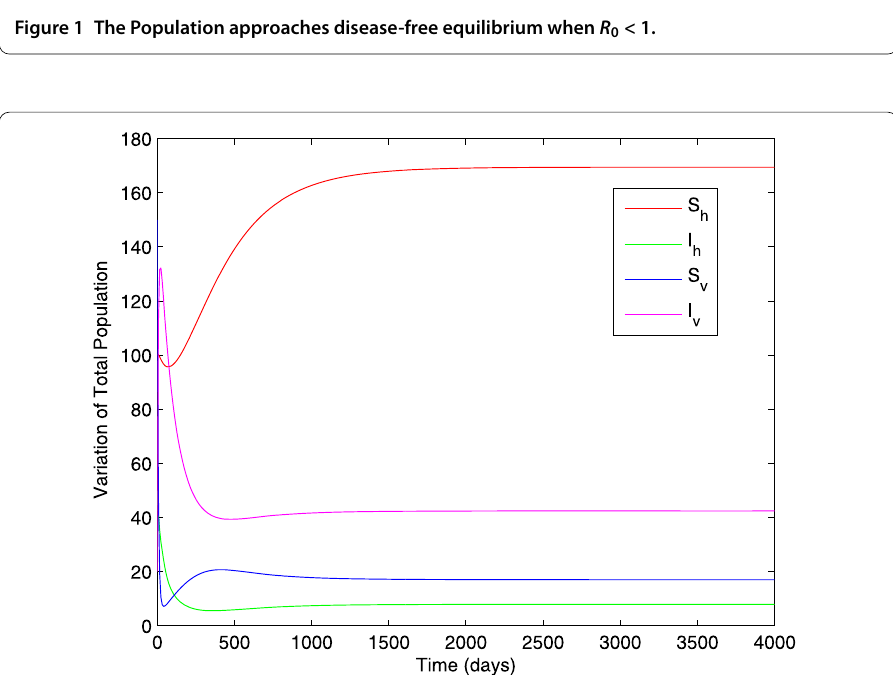
Figure 2 The Population approaches endemic equilibrium when R 0 >